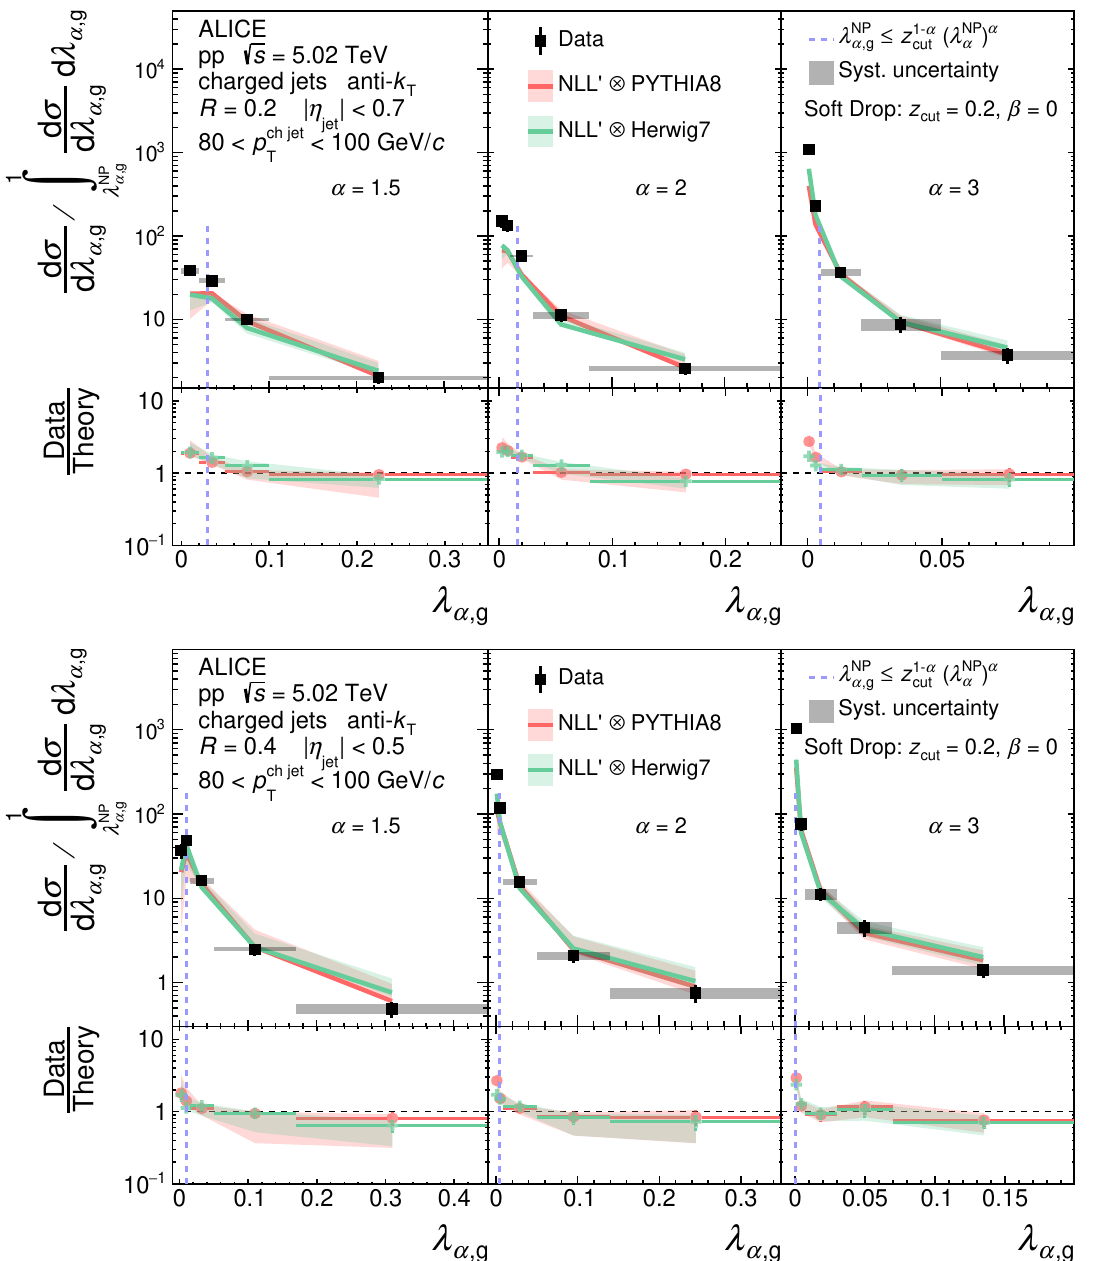
Figure 10 . Comparison of groomed jet angularities λ α, g in pp collisions for R = 0 . 2 (top) and R = 0 . 4 (bottom) to analytical NLL 0 predictions with MC hadronization corrections in the range 80 < p ch jet < 100 GeV /c . The distributions are normalized such that the integral of the perturbative T region defined by λ α, g > λ NP (to the right of the dashed vertical line) is unity. Divided bins are α, g placed into the left (NP)